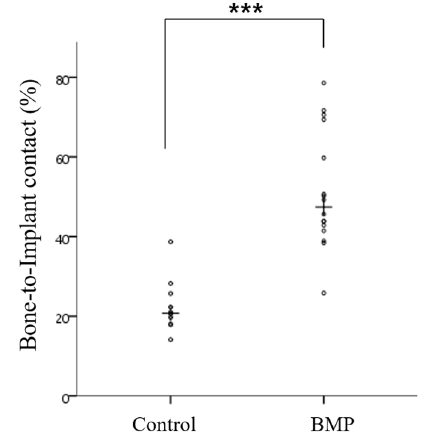
Figure 10. Scatter plot and median (the cross) representing the bone-to-implant contact (%) (*** p < 0.001).